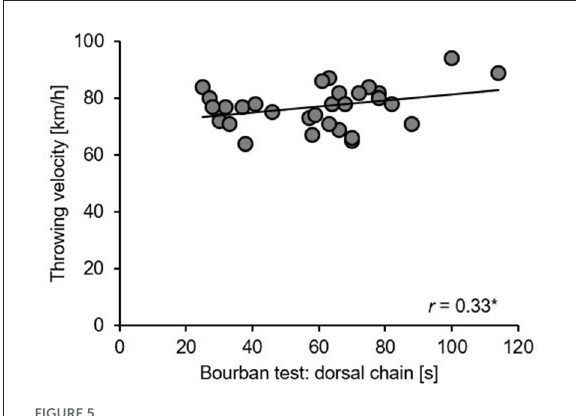
FIGURE5 Pearson‘s correlations between throwing velocity of the 7-m standing throw test and the dorsal chain of the Bourban test. *correlation is significant at the 0.05 level